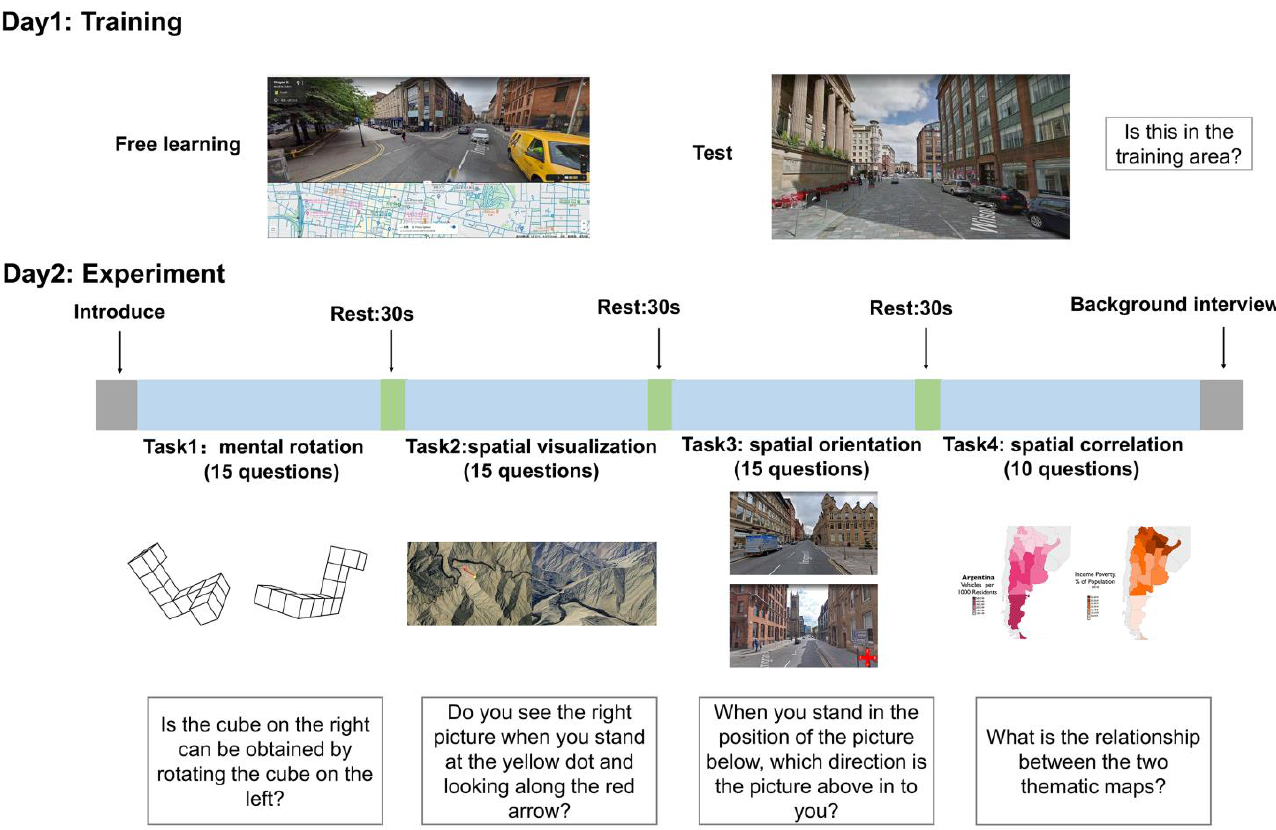
Figure 2. Figure 2. Procedure.